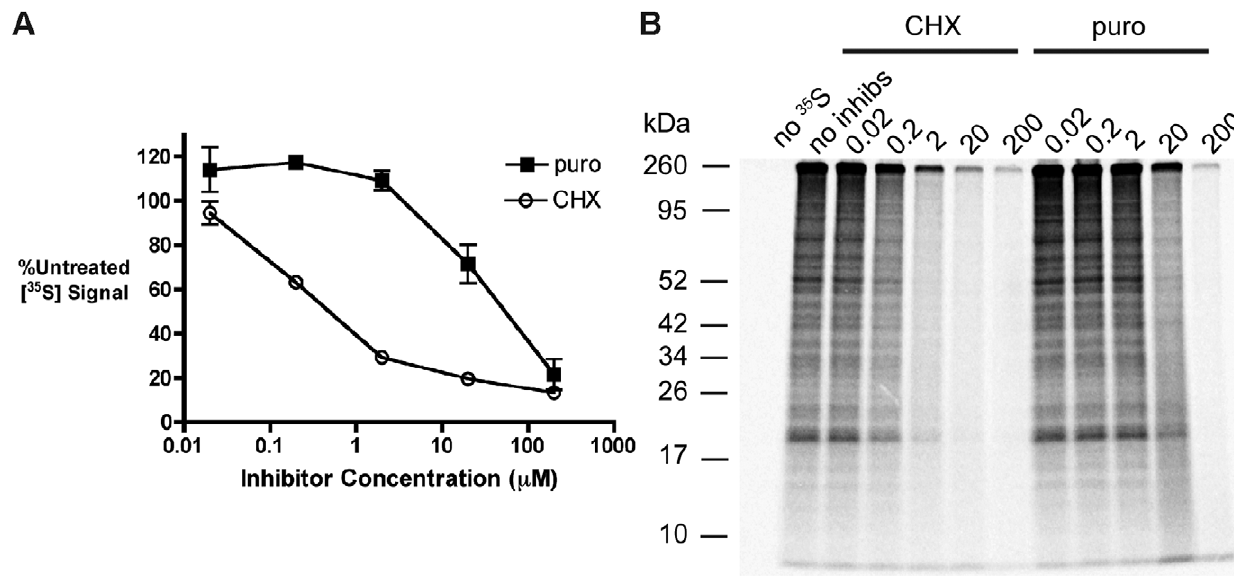
Figure 1. Contrasting effects of cycloheximide and puromycin on the profile of newly synthesized polypeptides. A. 293-K b cells were radiolabeled with [ 35 S]-Met for 10 minutes in the presence of varying concentrations ( m M) of CHX and puro, followed by precipitation of polypeptides with trichloroacetic acid (TCA). TCA precipitates were solubilized and radiolabel incorporation was measured by liquid scintillation counting. [ 35 S] signal was normalized to untreated controls ( n =3; mean 6 s.e.m.) B . Separation of TCA precipitates from samples in A by tricine SDS-PAGE in 10% gels. Gels were dried and exposed to a PhosphorImager plate overnight. Results are representative of three independent experiments.